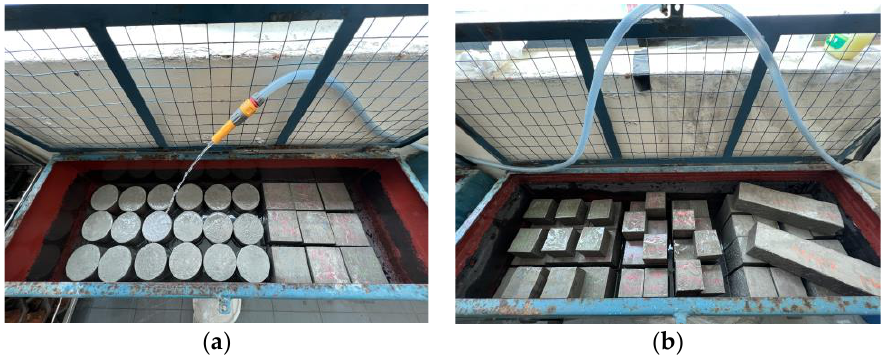
Figure 3. Preparation of samples: ( a ) cylinders and ( b ) cubes and beams.